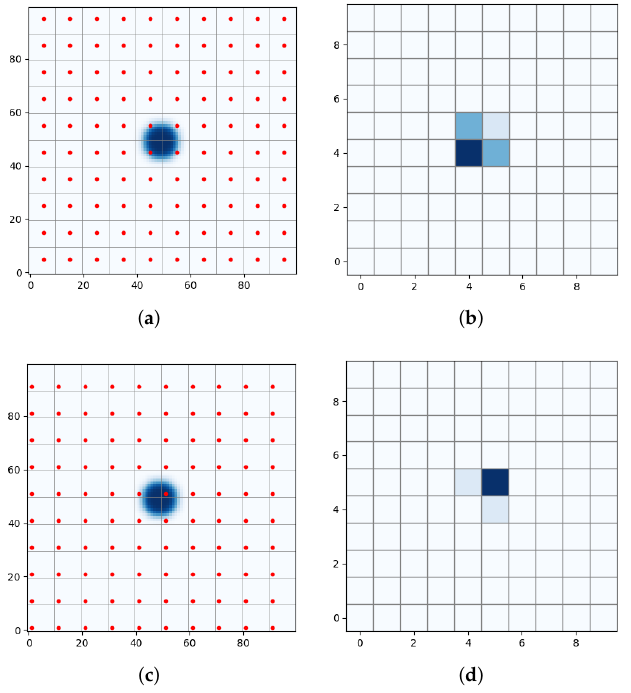
Figure 3. Illustration of aliasing effects due to differences in sampling. ( a ) Image after convolution with the PSF. Jitter 5,5 is represented by the red dots. ( b ) Image after sampling with jitter 5,5. ( c ) Image after convolution with the PSF. Jitter 1,1 is represented by the red dots. ( d ) Image after sampling with jitter